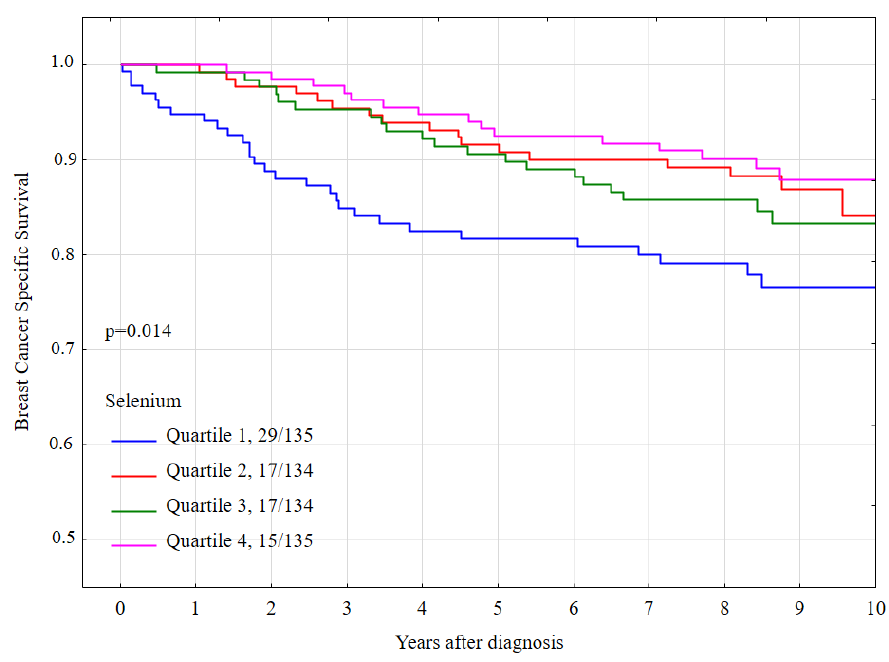
Figure 2. Ten-year breast cancer-specific survival by quartile of serum selenium levels, all women. Compared to women in quartile 4, the univariate hazard ratio (HR) for breast cancer- specific mortality for women in quartile 1 was 2.31 (95% CI 1.24–4.31, p = 0.008). (Table 3). Compared to women in quartile 4, the multivariate hazard ratio (HR) for breast cancer- specific mortality for women in quartile was 1.56 (95% CI 0.72–3.40) and this difference did not reach statistical significance ( p = 0.26) (Table 4). Table 3. Hazard ratio (HR) and 95% confidence intervals (CI) of all-cause and breast cancer-spe- cific mortality by various treatments and clinical characteristics: univariate analysis.